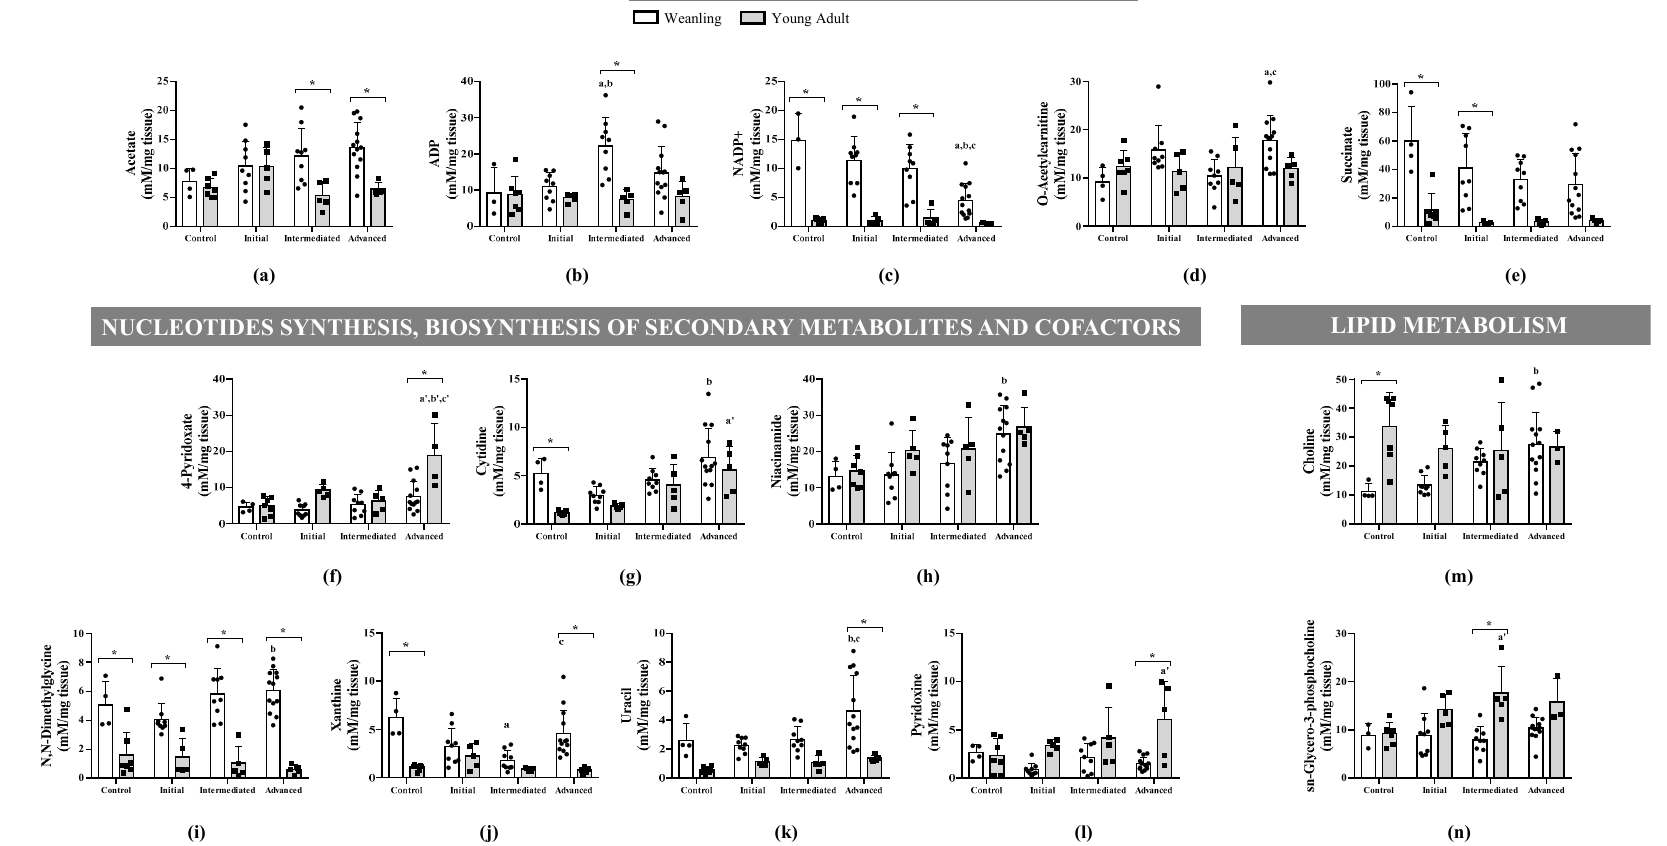
Figure 3. Gastrocnemius muscles’ metabolic profile of energetic metabolism ( a – e ), nucleotide synthesis and biosynthesis of secondary metabolites and cofactors ( f – l ), and lipid metabolism ( m , n ) identified in young and adult female Walker-256 tumour-bearing rats. Concentration of ( a ) acetate, ( b ) ADP, ( c ) NADP+, ( d ) o-acetylcarnitine, ( e ) succinate, ( f ) 4-pyridoxate, ( g ) cytidine, ( h ) niacinamide, ( i ) N,N-dimethylglycine, ( j ) xanthine, ( k ) uracil, ( l ) pyridoxine, ( m ) choline, ( n ) sn-glycero-3-phosphocholine metabolites distributed into weanling and young adult control (WC and AC) and initial (WWi and AWi), intermediate (WWm and AWm), and advanced (WWa and Awa) Walker tumour-bearing rats. Legend: Data are expressed as means ± standard deviation and analysed by two-way ANOVA, followed by post-hoc Tukey’s honestly significant difference. p -value < 0.05 in comparison with (a) WC, (b) WWi, and (c) WWm groups; with (a’) AC, (b’) AWi, and (c’) AWm groups; and with young adult (*) groups.